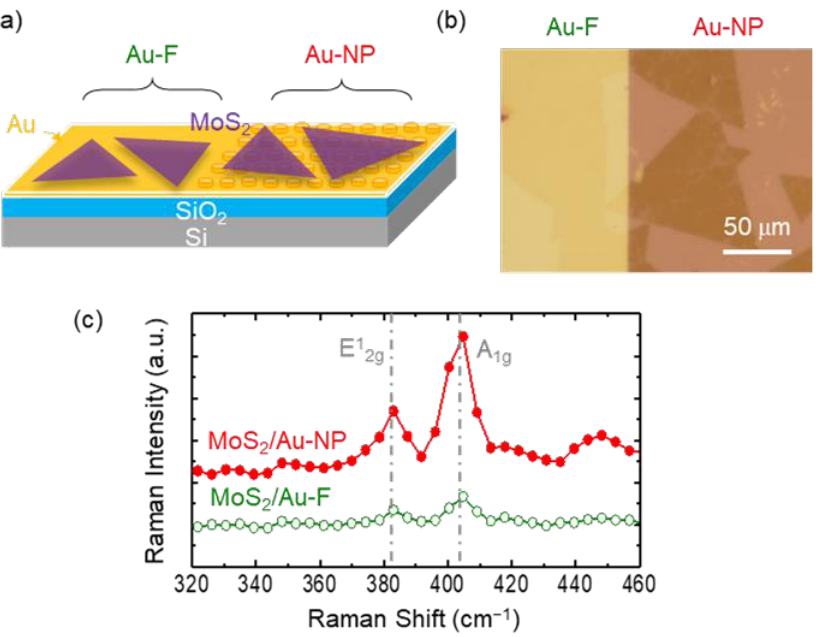
Figure 2. ( a ) Schematic illustration, ( b ) optical micrograph, and ( c ) micro Raman spectra of the MoS 2 flakes transferred onto the Au-F and Au-NPs. flakes transferred onto the Au-F and